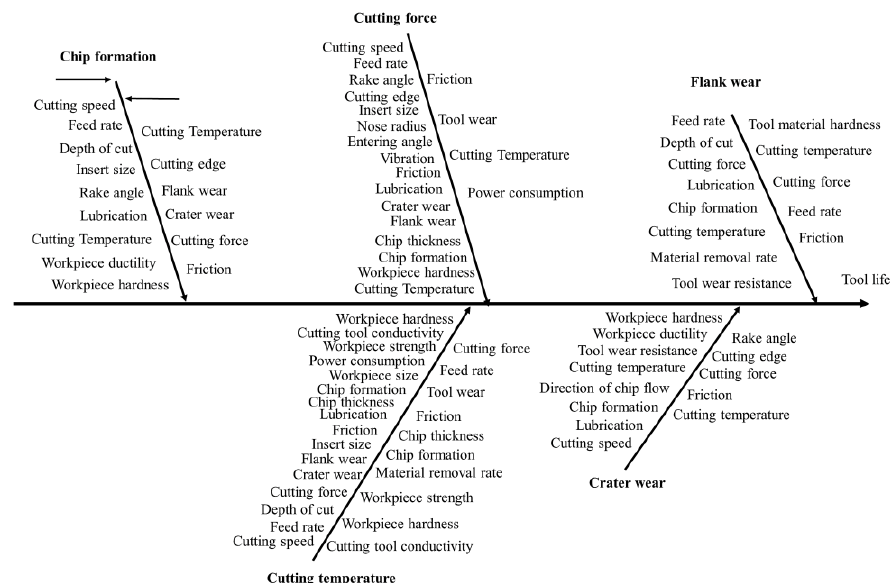
Figure 9. The cause-and-effect diagram of parameters affecting tool life in the turning process of metal cutting. metal